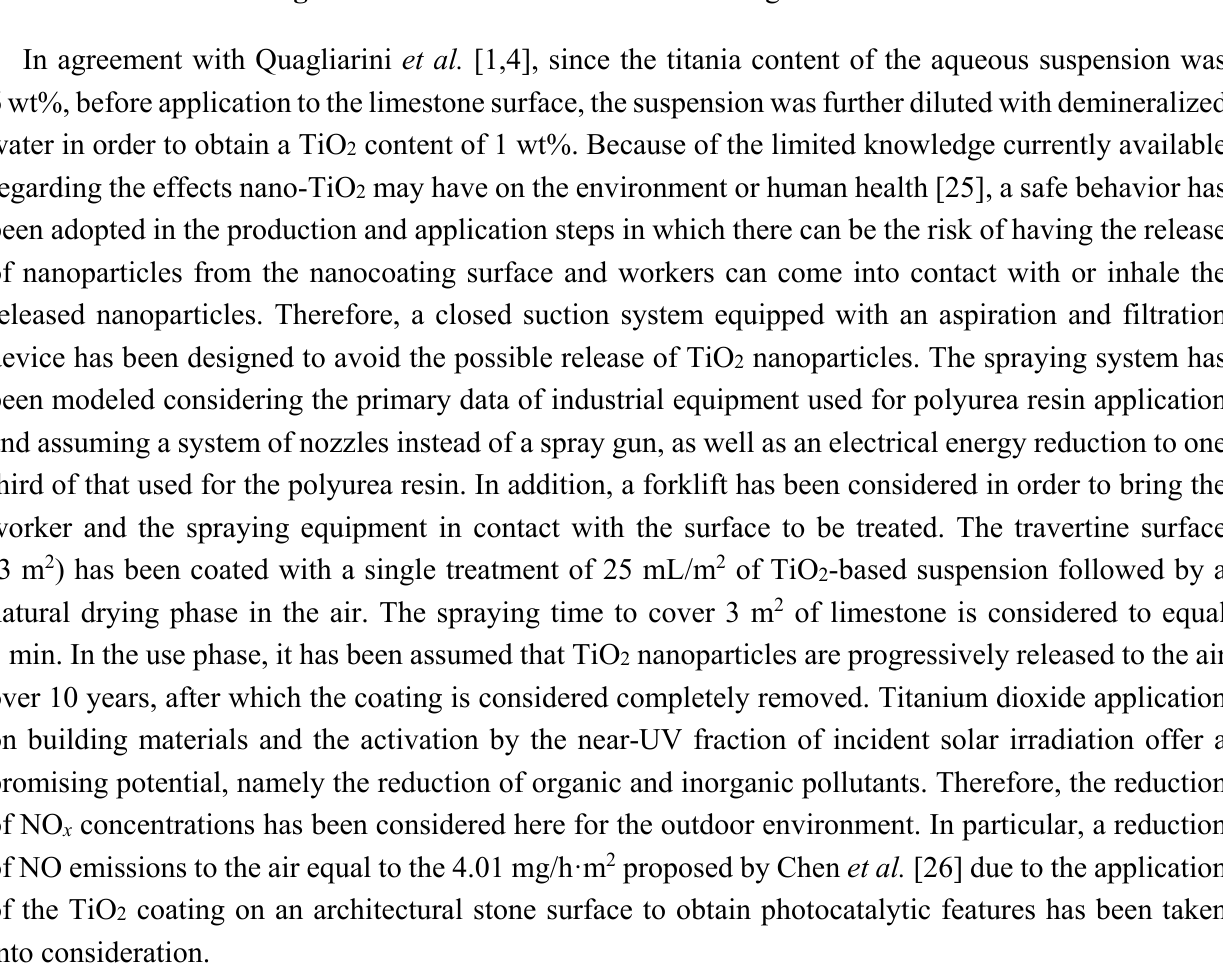
Figure 1. Flow chart of nano-TiO 2 coating on